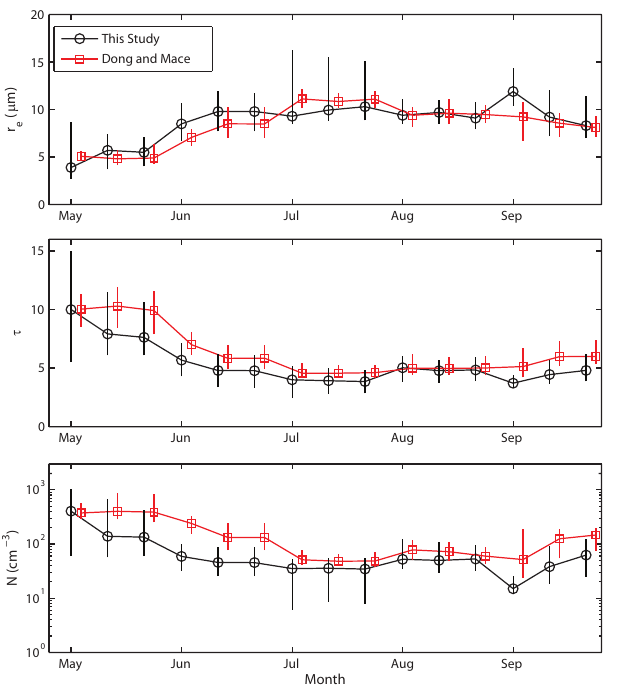
Fig. 13. Calculated in 10-day intervals for the period May to September between 2000 and 2003, retrieved cloud droplet effec- tive radius r e , visible optical depth τ , particle number concentration N , using two methods: the method described here (black), and an independent technique based on shortwave transmission and MWR LWP retrievals developed by Dong and Mace (2003b). For the in- tercomparison, retrievals are constrained to a range of LWP values between 20gm − 2 and 40gm − 2 . Bars represent the range in quar- tiles.